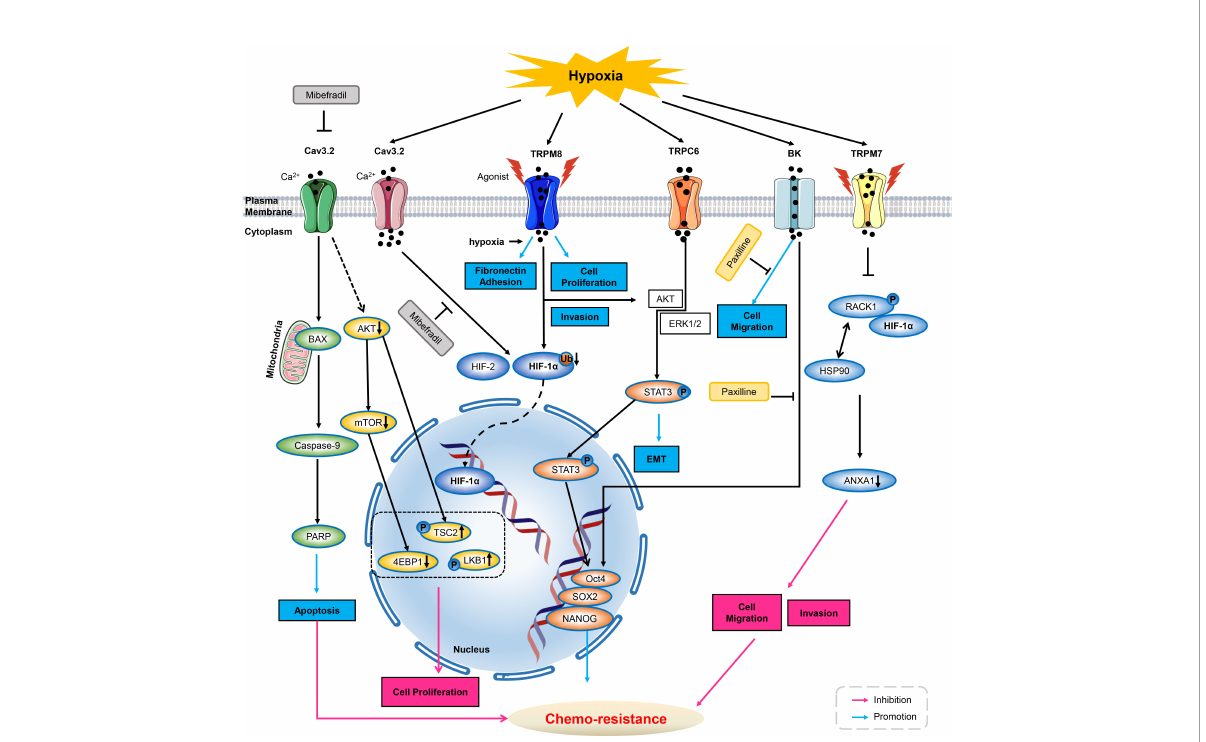
FIGURE 1 Ion channels modulate chemo-resistance through tumor microenvironment. As inhibitor of T-type calcium ion channels, mibefradil suppresses Cav3.2 ion channel activity, and then decreases AKT, mTOR and 4EBP1 activities and up-regulated phosphorylation of LKB1 and Tuberin/TSC2, thus inhibiting cell proliferation. Meanwhile, inhibiting Cav3.2 by mibefradil activates BAX, caspase-9, PARP, thus enhancing GSCs apoptosis. Cav3.2 can be up-regulated by hypoxia, and application of Cav3.2 inhibitor of mibefradil inhibits HIF-1 a and HIF-2 in GSCs. In hypoxia, menthol or icilin stimulation promotes cell proliferation and invasion. Simultaneous hypoxia stimulation increases fi bronectin adhesion and further enhances menthol treatment. TRPM8 over-expression enhances HIF-1 a in hypoxia-exposed prostate cancer cells by reduction of HIF-1 a ubiquitination. Hypoxia increases the expression of TRPC6, then activates AKT/ERK1/2 to promote phosphorylation of STAT3, inducing its nucleus translocation, triggers the expression of Oct4, SOX2 and NANOG, thus deteriorating chemo-resistance. HIF-1 a increases upon BK channel blocker of Paxilline in GBMs. Hypoxia increased expression and the nuclear translocation of stemness markers of Oct4, NANOG and SOX2, therefore increasing chemo-resistance to Paxilline in GBMs. Hypoxia increases TRPM7 expression and enriches HIF-1 a in prostate cancer cells. Suppression of TPRM7 enhances phosphorylation of RACK1 and promotes the binding of RACK1 to HIF-1 a by competing with HSP90, then inhibiting downstream signaling of ANXA1 to suppress the migration and invasion, thus weakening chemo-resistance in prostate cancer cells. GSC, glioblastoma stem-like cells; HIF, hypoxia inducible factors; AKT, protein kinase B; mTOR, mammalian target of rapamycin; BK, calcium-activated potassium channels; GBM, glioblastoma; PARP, poly ADP-ribose polymerase; ANXA1, Annexin A1; ERK1/2, extracellular regulated protein kinases1/2; STAT3, signal transducer and activator of transcription